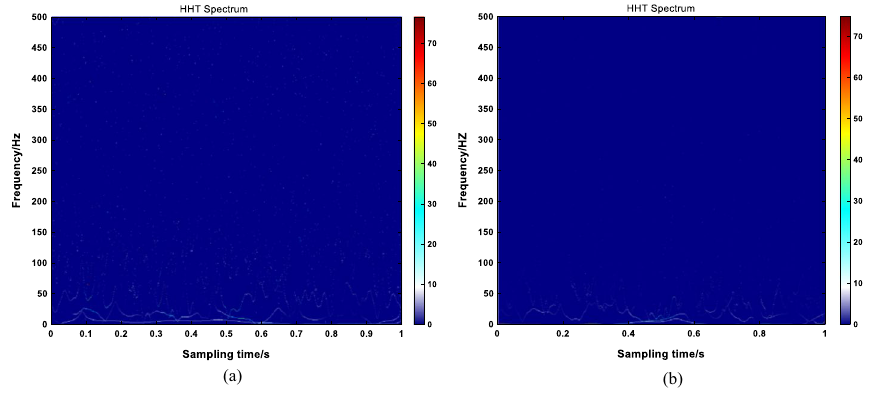
Fig. 6 HHT spectrum of signals before and after IMMF